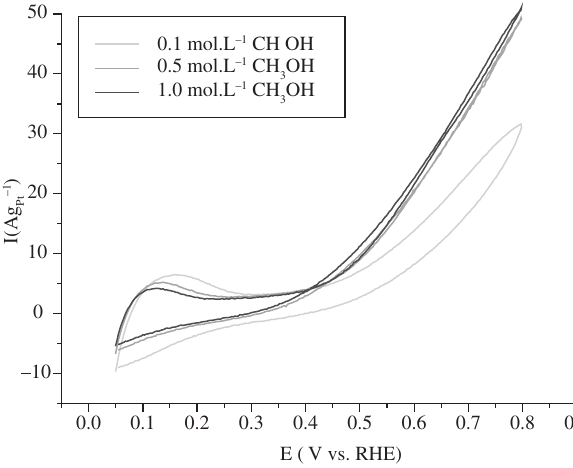
Figure 2. Cyclic Voltammograms of PtRu/C electrocatalysts prepared using electron beam irradiation and commercial PtRu/C electrocatalyst in 0.5 mol.L –1 H SO with a sweep rate of 10 mV.s –1 . 2 4